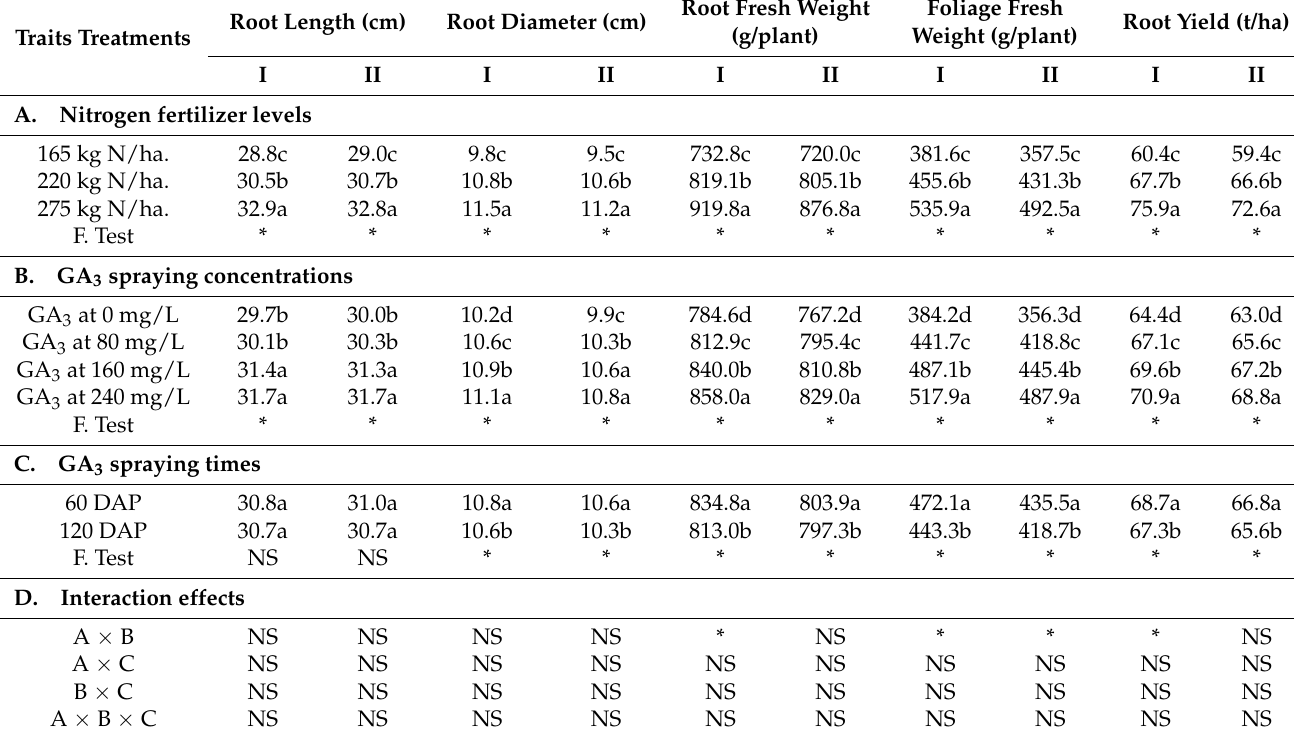
Table 2. Means of root length (cm), root diameter (cm), root fresh weight (g/plant), foliage fresh weight (g/plant), and root yield (t/ha) as affected by nitrogen fertilizer levels and gibberellic acid (GA 3 )spraying concentrations and its application time in the 2014/2015 (I) and 2015/2016 (II)